Question: Produce a descriptive caption suitable for publication.
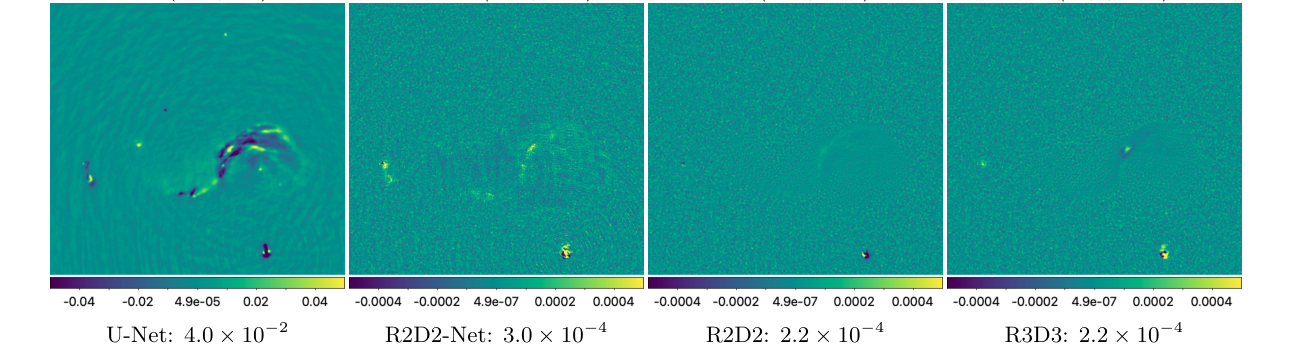
Answer: Experiment IV: reconstructions results of the radio galaxy Messier 106. The first and third rows show the ground truth image and the estimated images obtained by the imaging algorithms (logarithmic scale). The second and fourth row shows the dirty image and the corresponding residual dirty images (linear scale). For R3D3, we showcase the results of its realization with J = 6 layers in its R2D2-Net components. Values of (SNR, logSNR) are reported below estimated images. The σres. values are indicated below the residual dirty images.